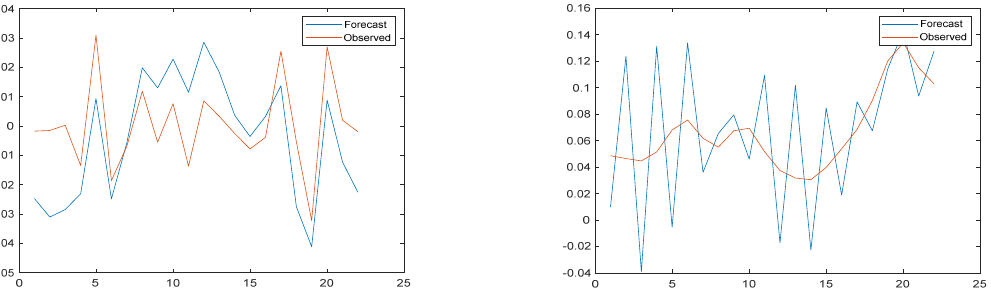
Figure 11. Prediction results and error images of the ANN-WT-LSTM model for high-frequency and low-frequency parts of the TP verification set.